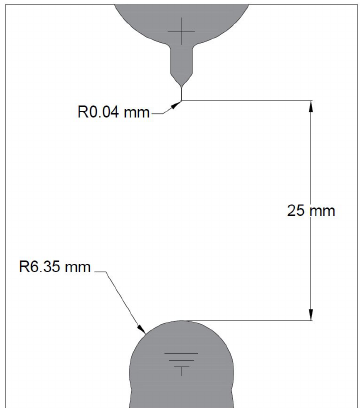
Figure 1. Geometry corresponds to International Electrotechnical Commission (IEC)-60897 [10].